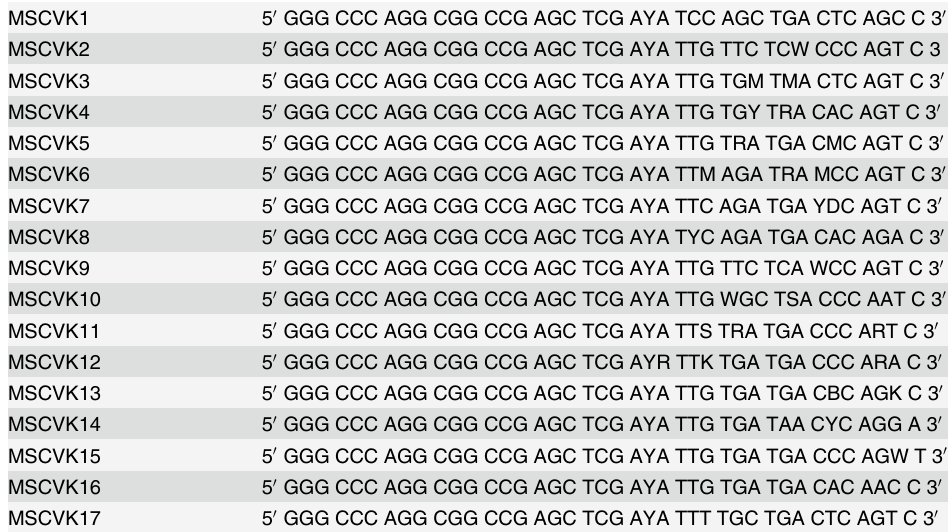
(reverse) was 5 0 GAG GAG GAG GAG GAG GAG CCT GGC CGG CCT GGC CAC TAG TG 3 0 . The PCR products were gel extracted and pooled together, restriction digested with SfiI and ligated into SfiI digested pCOMB3xSS. Subsequently, the ligated product was transformed into electro competent cells via electroporation and the library was titered. 10 clones from the library were analysed by restriction digestion using SfiI to calculate the insert percentage. Biopanning using the NCD1.2:scFv phage library Phage preparation: Phage displaying scFv library was grown and rescued overnight at 30°C using helper phage M13KO7. The overnight phage library was centrifuged at 9000rpm for 20 mins. The phage supernatant was transferred to fresh tubes and 2g of PEG (4%) along with 1.5g NaCl (3%) were added. This mixture was incubated at 37°C shaking at 220rpm until fully dissolved. The cultures were again spun down at 9000rpm for 20 mins at 4°C and dry inverted for 10 minutes. This input phage was then added to the immunotube (pre-coated with 1 μ g/ml Table 2. V к chain 5 ’ primers: MSCVK 1 – 17 for construction of a murine scFv library